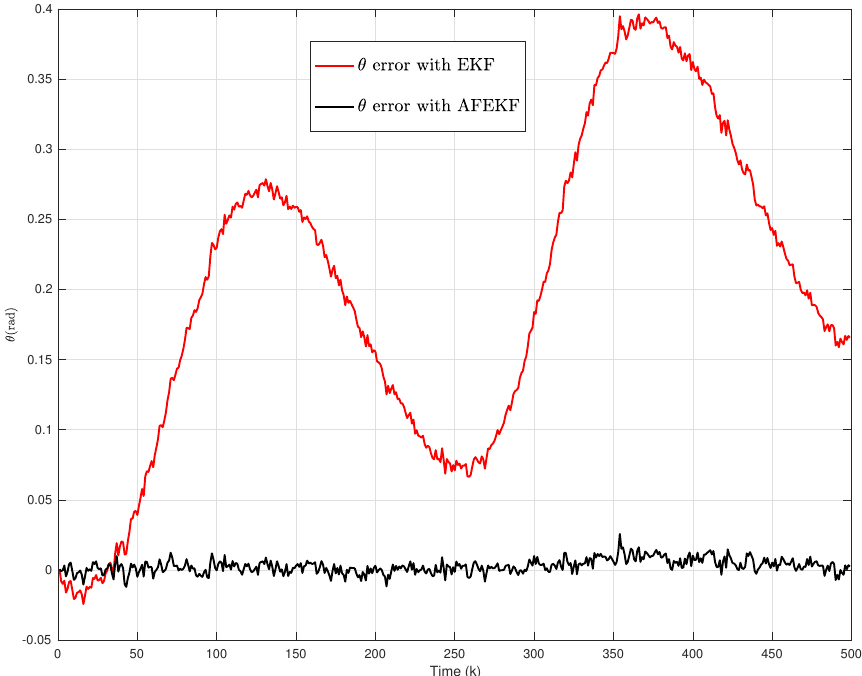
Figure 5. Robot’s angle errors under constant bias.